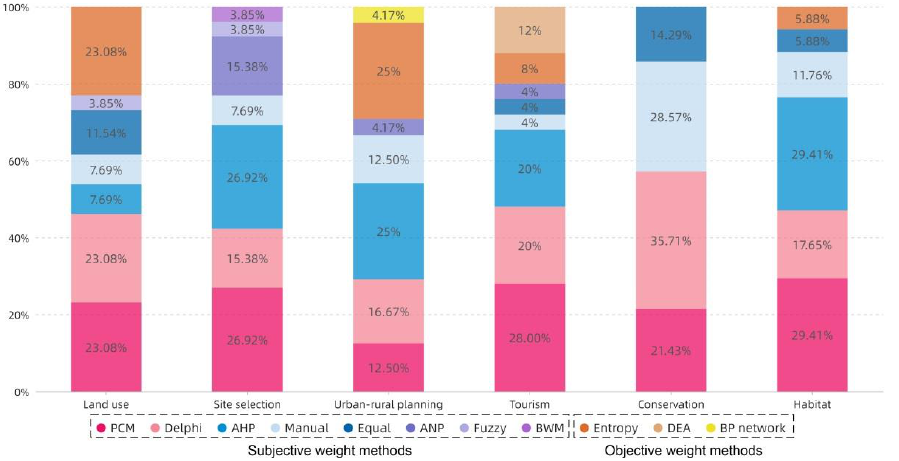
Figure 13. The annual distribution of occurrences of the weighting methods.